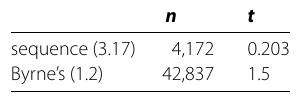
Table 3 (cid:2) = 10 –5 , P = 10, M = 5, N = 5